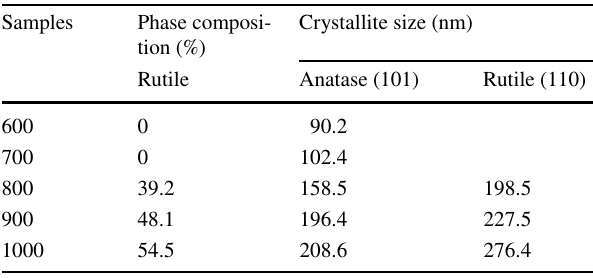
Table 1 Phase composition of anatase and rutile and the correspond- ing crystallite sizes in PTC composites annealed at different tempera- tures